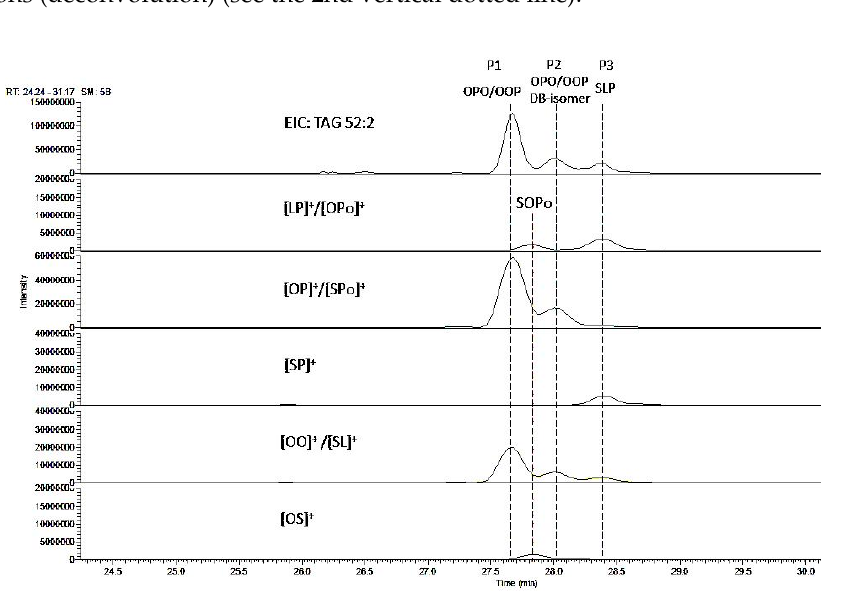
Figure 3. LC-MS (EIC) profile of TAG 52:2. Alignment of the parent ion ( m / z 876.8) with the fragment ions m / z 575.5 ([LP] + or [OPo] + ), 577.5 ([OP] + or [SPo] + ), 579.5 ([SP] + ), 603.5 ([OO] + or [SL] + ), and 605.5 ([OS] + ), allowing assignment of the three peaks as OPO/OOP mixture (Peak 1), OPO/OOP DB-isomers (Peak 2), and SLP (Peak 3); noting the presence of isobaric fragment ions [LP] + /[OPo] + , [OP] + /[SPo] + , and [OO] + /[SL] + for this TAG group. L: linoleic acid; P: palmitic acid; Po: palmitoleic acid; O: oleic acid; S: stearic acid.